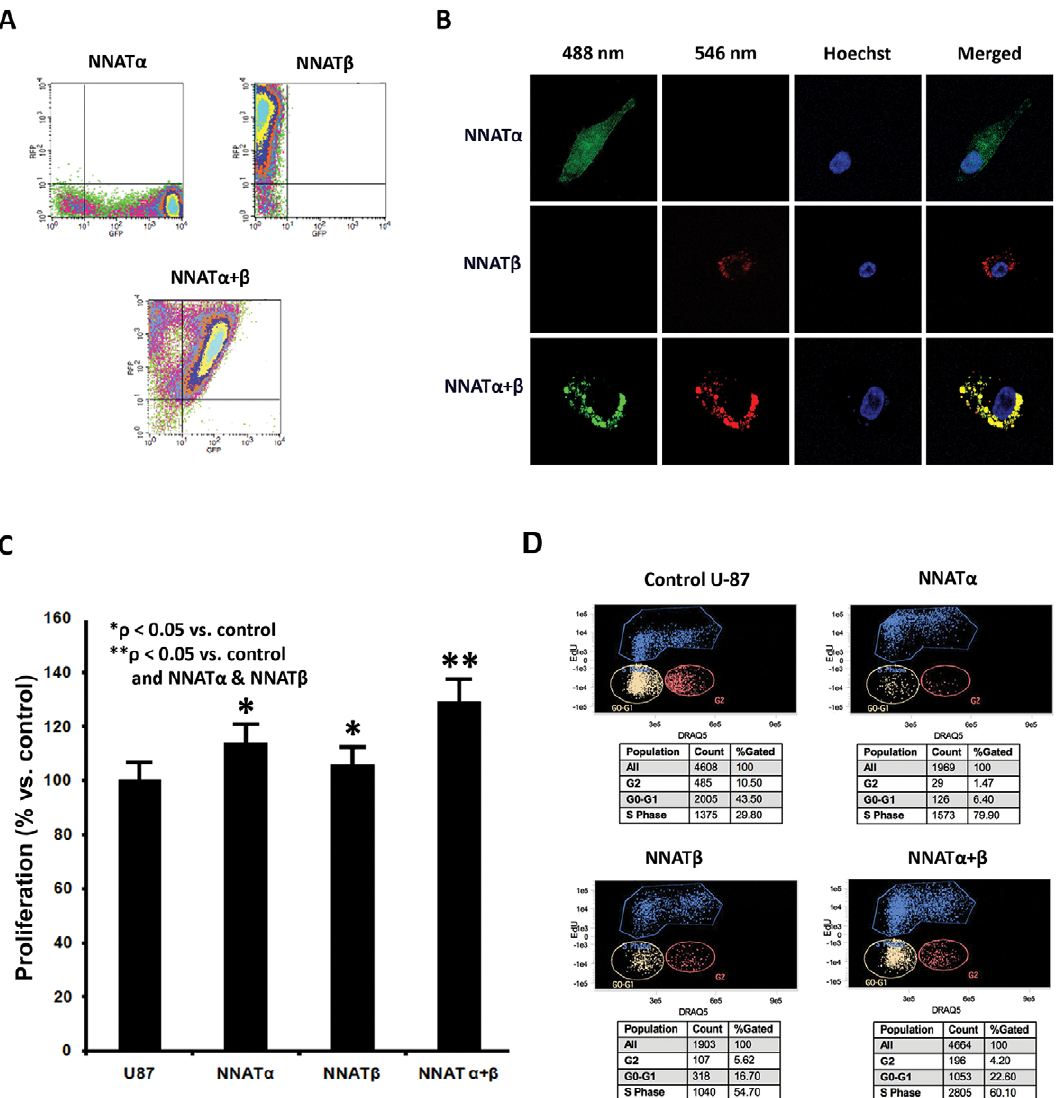
Figure 3. Expression of NNAT is Associated with Increased Cellular Proliferation. GFP-tagged NNAT a and RFP-tagged NNAT b were transfected alone or in conjunction into U87 glioma cells. The cells were grown in antibiotic selection media utilizing G418 and underwent FACS (A) repeatedly over the course of 5 weeks to select a stably transfected population with at least 2 log-fold increase in fluorescent protein expression compared to controll. (B) The cellular distribution of NNAT a was predominantly membrane bound, with some cytoplasmic localization as well. NNAT b was more strongly localized in the cytoplasm, and when coexpressed, the two isoforms were found to strongly co-localize with NNAT a expression moving more into the cytoplasm. (C) Utilizing a colorimetric MTT proliferation assay, expression of either form of NNAT dramatically increased the proliferation profile of the U87 cells versus control. Coexpression of both isoforms caused an increase in proliferation that was greater than expression of either isoform alone. (D) Using a fluorescent activated cell sorting based proliferation demonstrated high percentage of S-phase cells in the NNAT a (79.9%) and NNAT b (54.7%) cell lines versus control (29.8%). Coexpression of both NNAT isoforms also yielded a higher population of S- phase cells